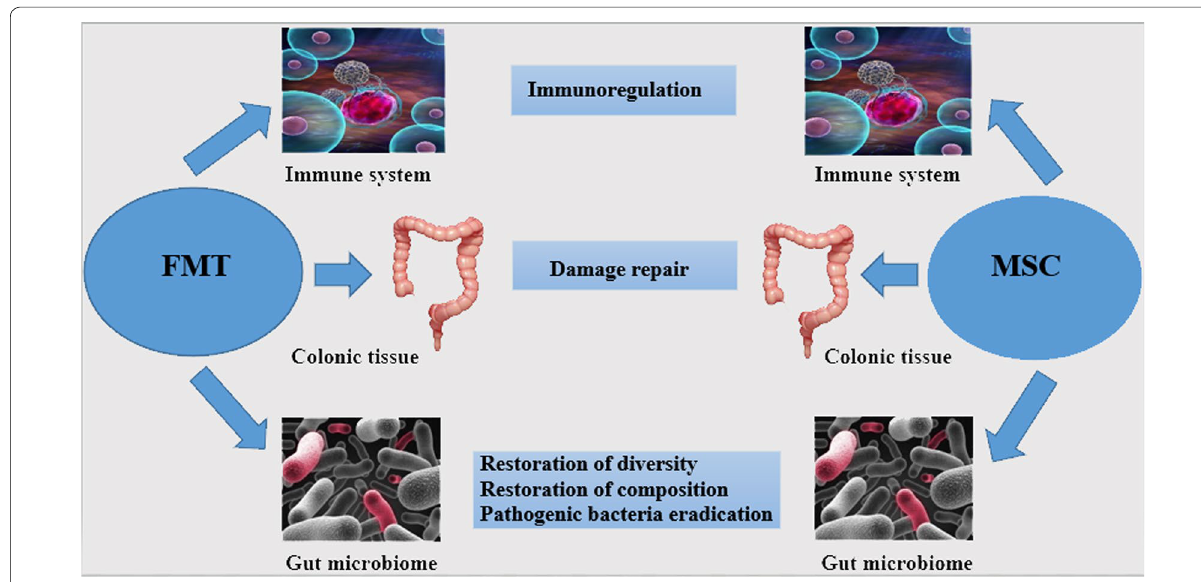
Fig. 2 General therapeutic points of connection between FMT and MSC-therapy in IBD. The three main desired functional effects of the two transplants are immunoregulation aimed at dampening inflammation, tissue damage repair via proliferation and remodeling, and gut microbiota restoration including elimination of pathogenic